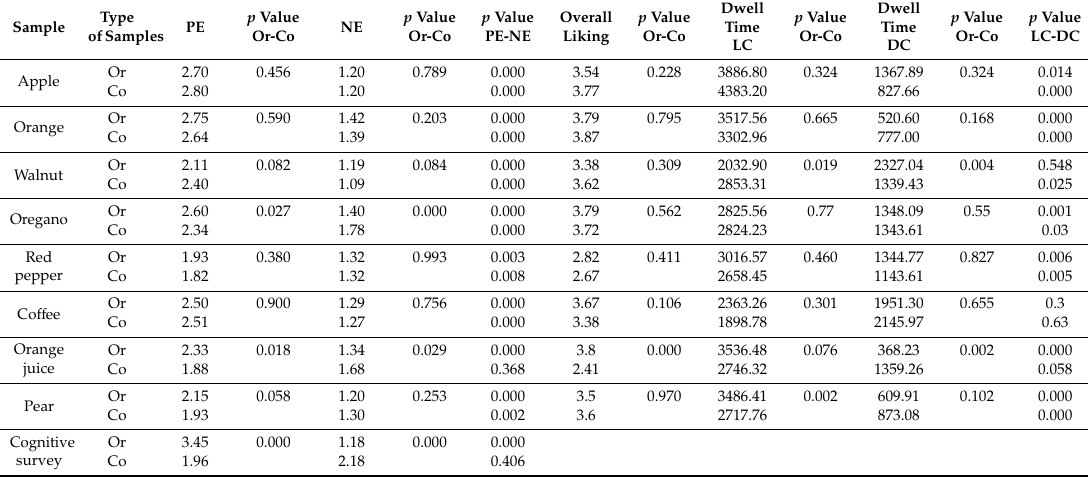
Table A1. Means and significant values of food-elicited emotion, food-declared emotions, overall liking, and dwell time on the color